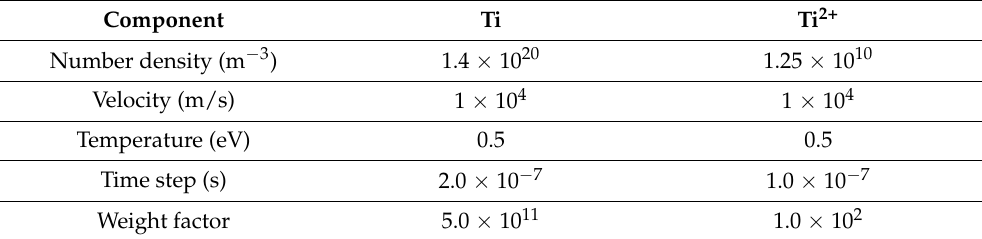
Table 1. Hybrid DSMC/PIC algorithm injection parameters.